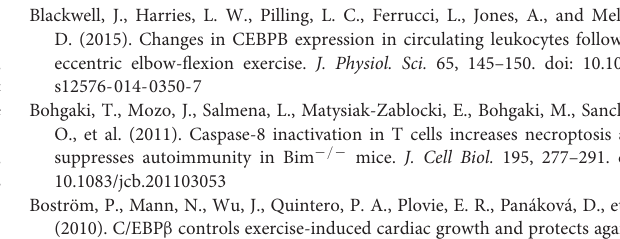
Supplementary Figure 1 | PPI network of mRNAs in the analysis of necroptosis-related lncRNAs–mRNAs correlation. Supplementary Figure 2 | Differential analysis of neuronal cell sensitivity to drugs in high and low AD